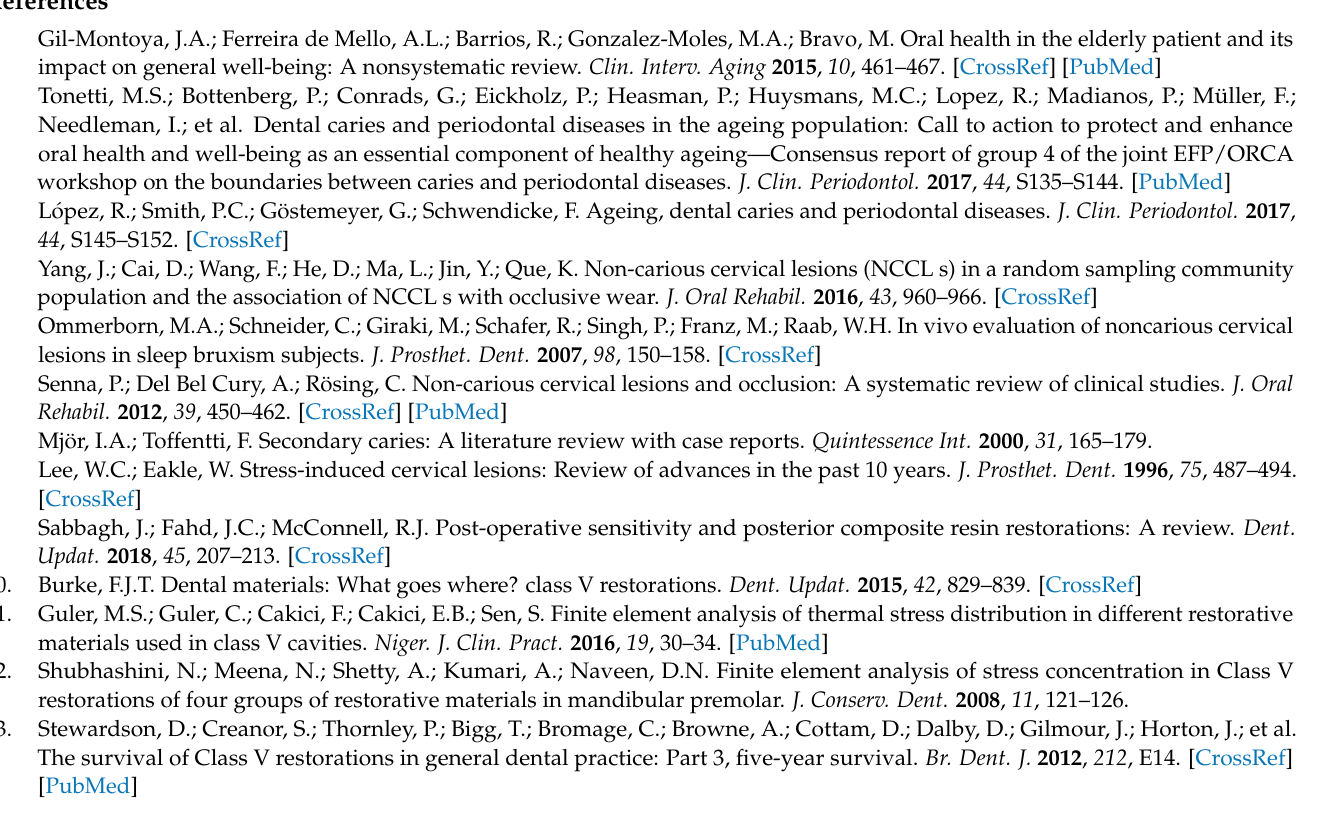
stress distribution (MPa) under 2 central vertical loads of 100N. (A) Buccal view, (B) Mid-cut view; Figure S3: Von Mises stress distribution (MPa) under buccally oriented oblique load of 200 N on buccal cusp. (A) Buccal view, (B) Mid-cut view; Figure S4: Von Mises stress distribution (MPa) under 60 ◦ C thermal condition; Figure S5: Von Mises stress distribution (MPa) under 4 ◦ C thermal